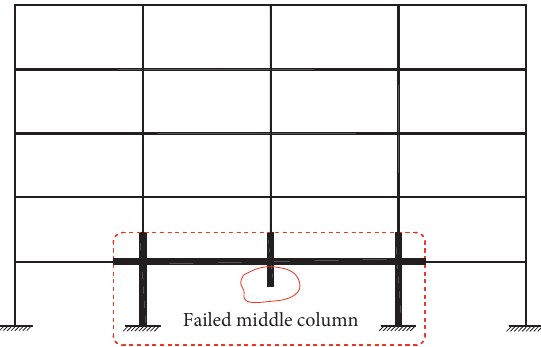
Figure 1: Location of the substructures in the prototype